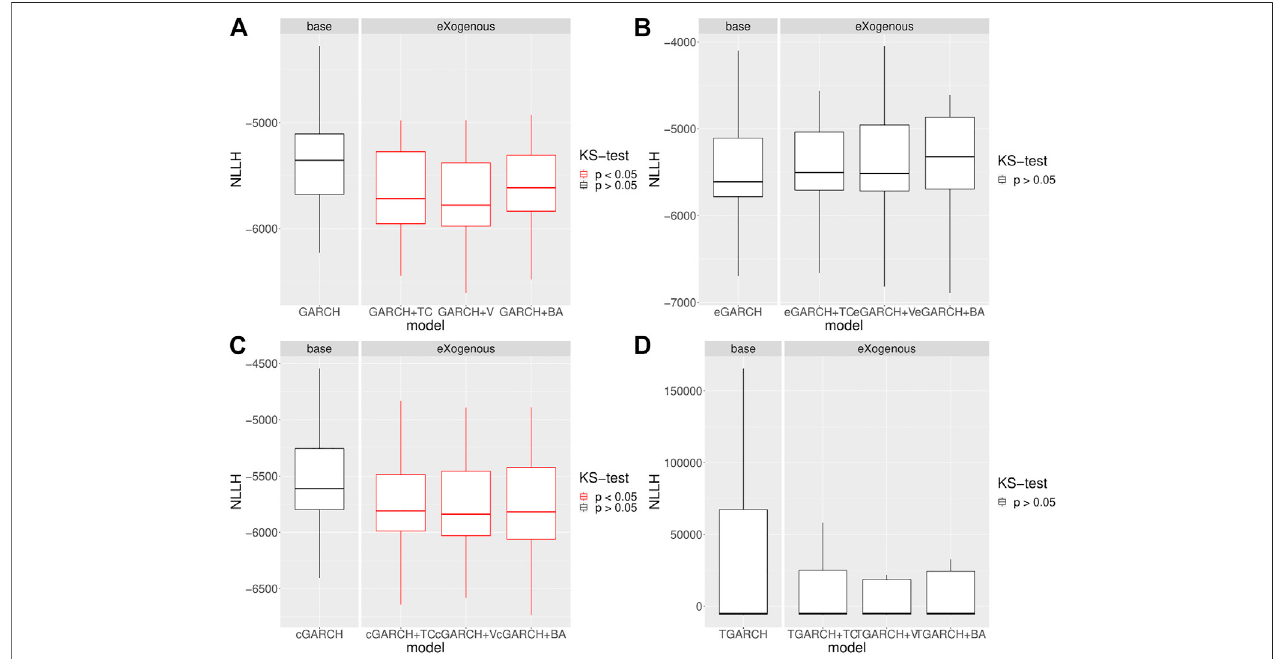
FIGURE8| Bootstraprobustnesscheck over N (cid:1) 100splitting points with T (cid:1) 1,000 training points and T (cid:1) 1,000test sizeforGARCH and GARCHX models. The price isde fi ned as mid-quote. The nonparametricKolmogorov – Smirnov test ofthe equality ofthe NLLH out-of-sample distributions between the GARCH and GARCHX models isdone. (A) KS test implies asigni fi cantdifference for both external signals for theGARCH model. (B) KStest impliesnosigni fi cantdifference for external signals fortheeGARCH model. (C) KStest implies nosigni fi cantdifference forboth externalsignals forthecGARCHmodel. (D) KS testimplies nosigni fi cantdifference for external signals for the TGARCH